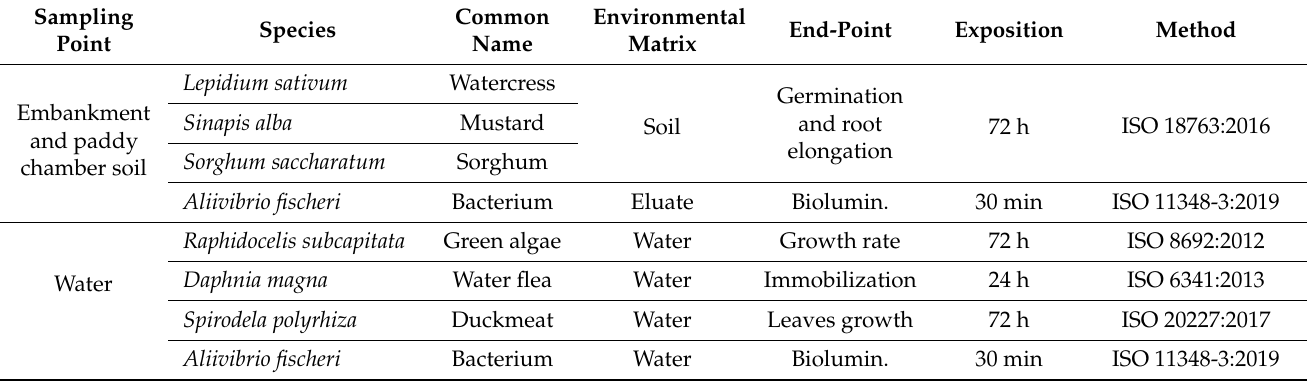
Table 2. Battery of bioassays used for ecotoxicological assessment of soil and water samples of rice